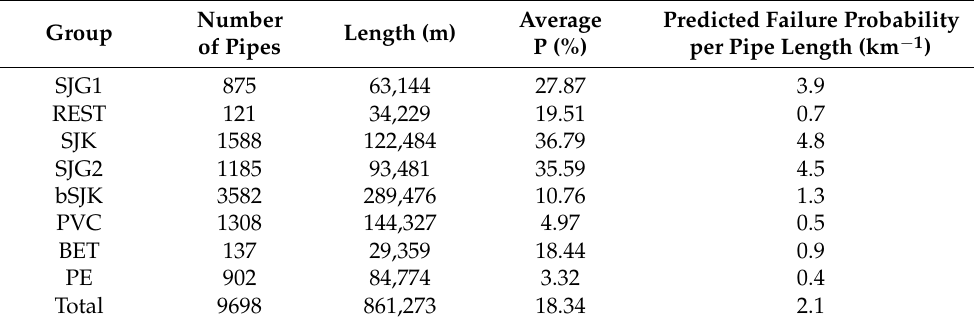
Table 5. Predicted failure probability in 5 years based on pipe material